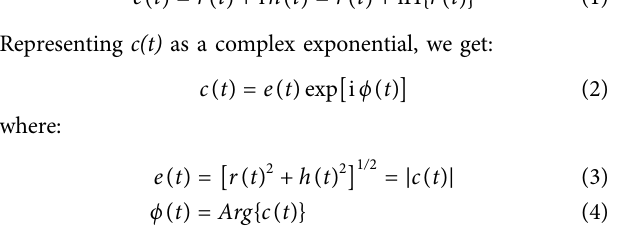
Frontiers in Earth Science |